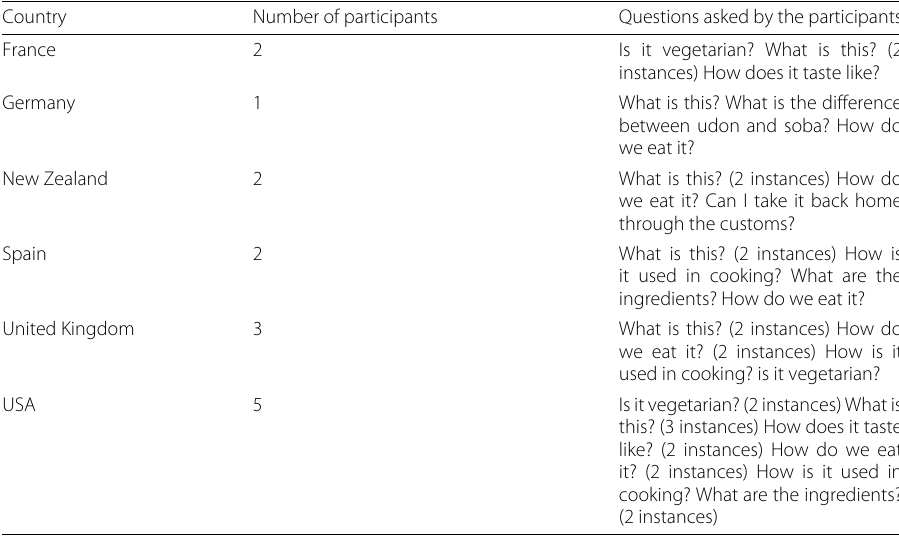
Table 1 Categorization of questions asked by tourists by country